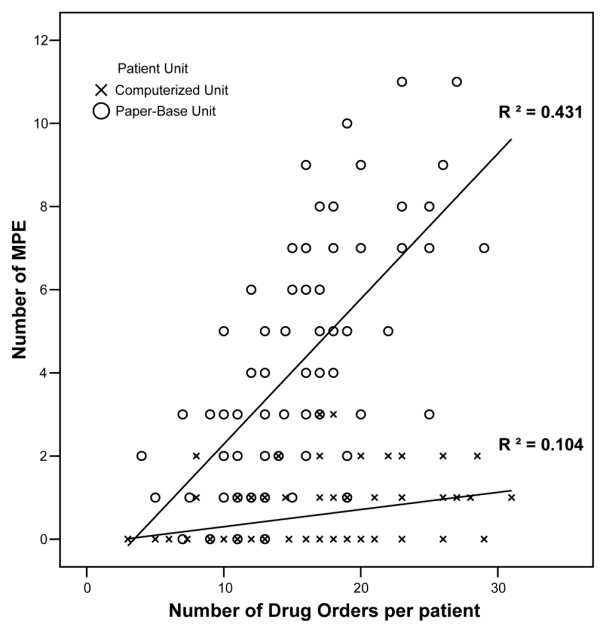
Scatter plot of number of medication prescribing errors (MPEs) at screening day according to number of drug orders per patient (24 hour screening day).